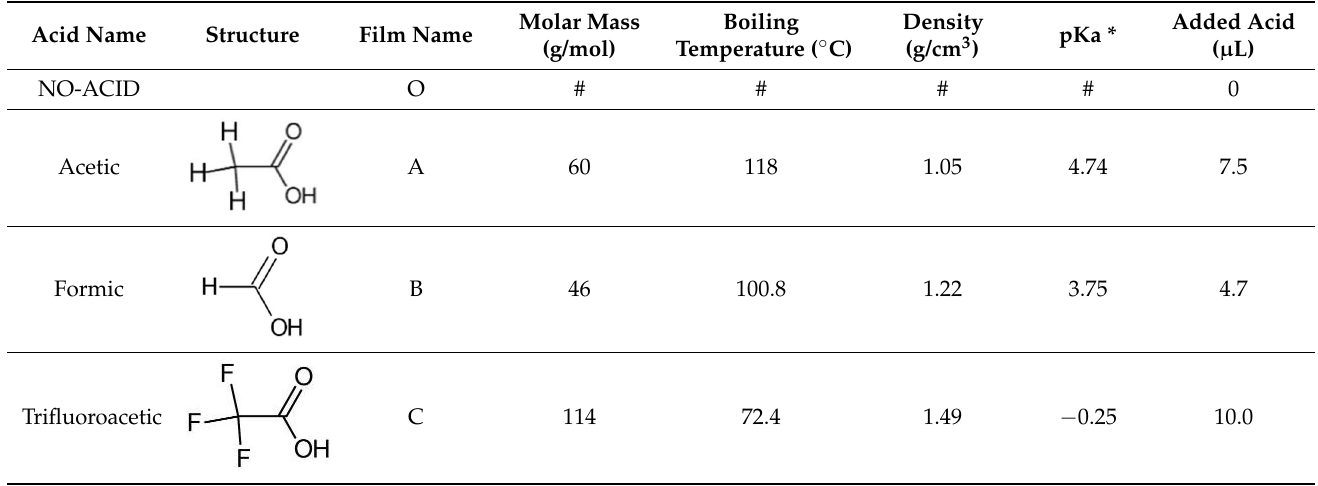
Figure 1. SEM images (top view) at different magnifications of films prepared under the conditions reported the Materials & Methods section. The films are named O (no acid additive), A (acetic ac- id), B (formic acid), C (trifluoracetic acid). Table 1. Acid additives details.